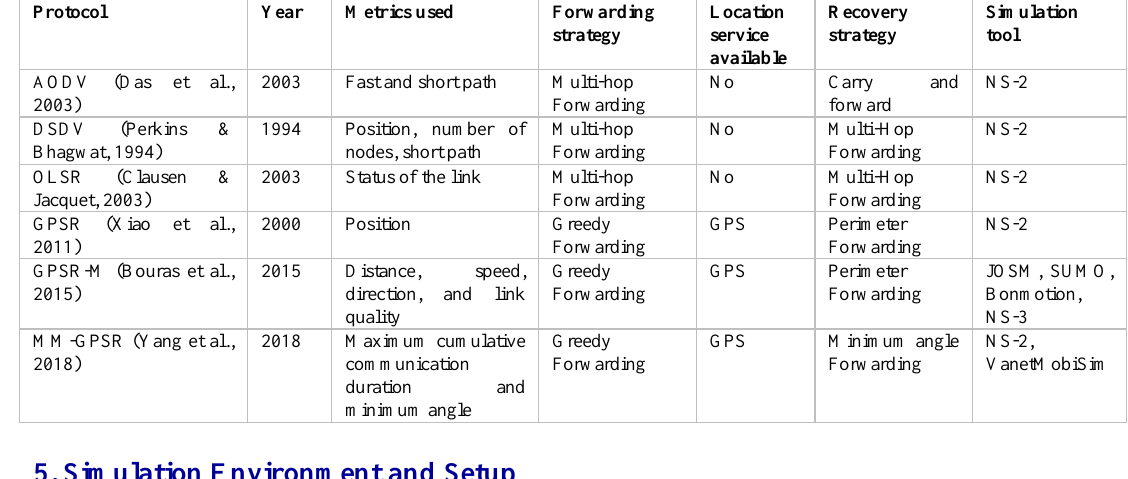
Table1. Comparison of TBR and PBR protocols.